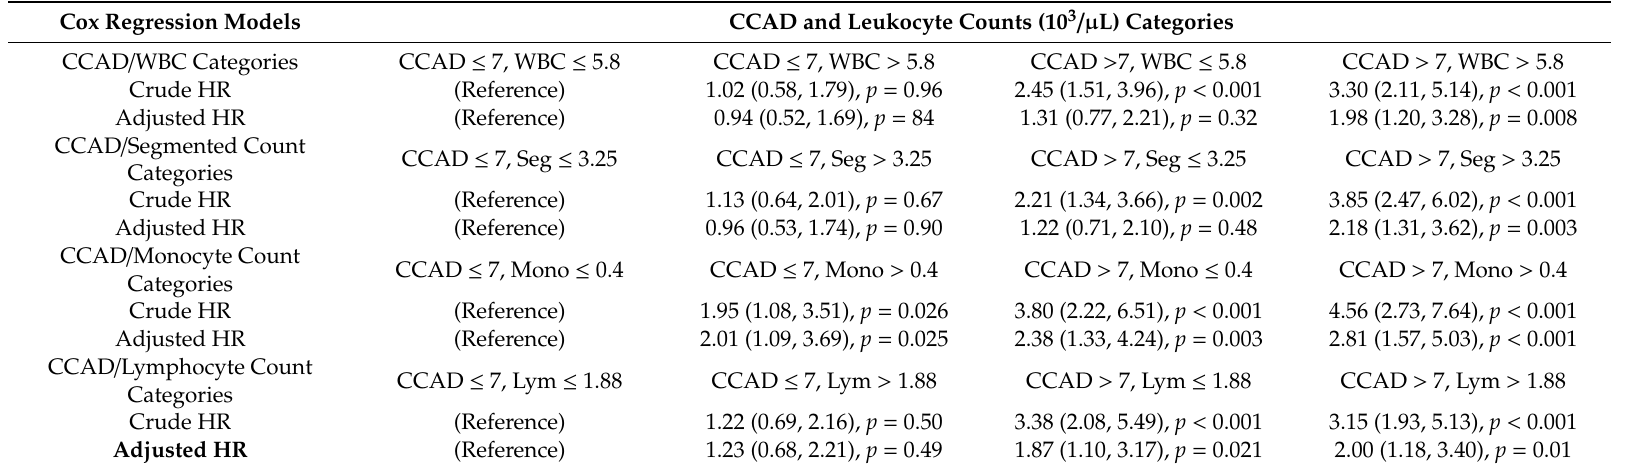
Table 4. Multivariate Cox regression models for the composite endpoints of HF and all-cause mortality based on the CCAD / leukocyte categories. Cox Regression